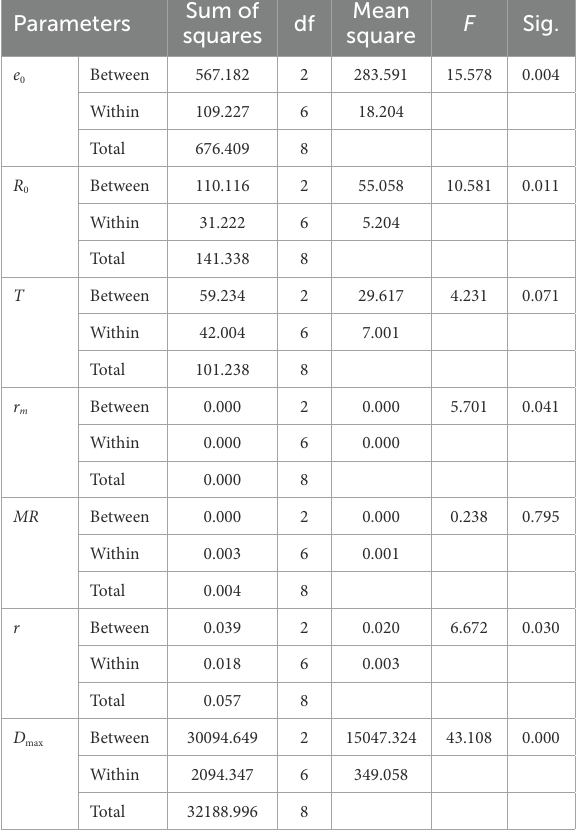
TABLE 1 The one-way ANOVA of life history and population growth parameters in B. calyciflorus . Parameters